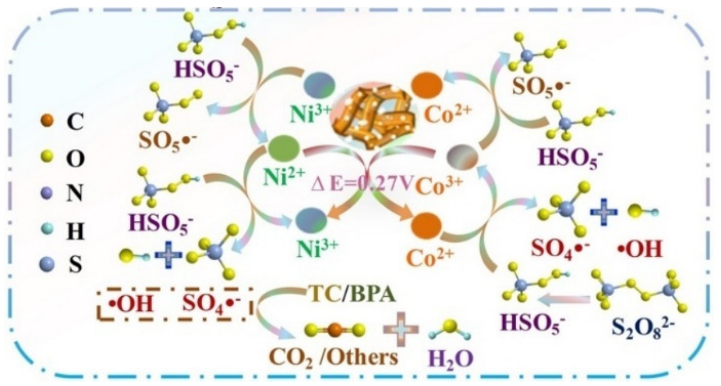
Figure 1. The recycle of Ni 2+ /Ni 3+ and Co 2+ /Co 3+ and the removal mechanism of TC and BPA in the NiCo 2 O 4 /PMS system [52].